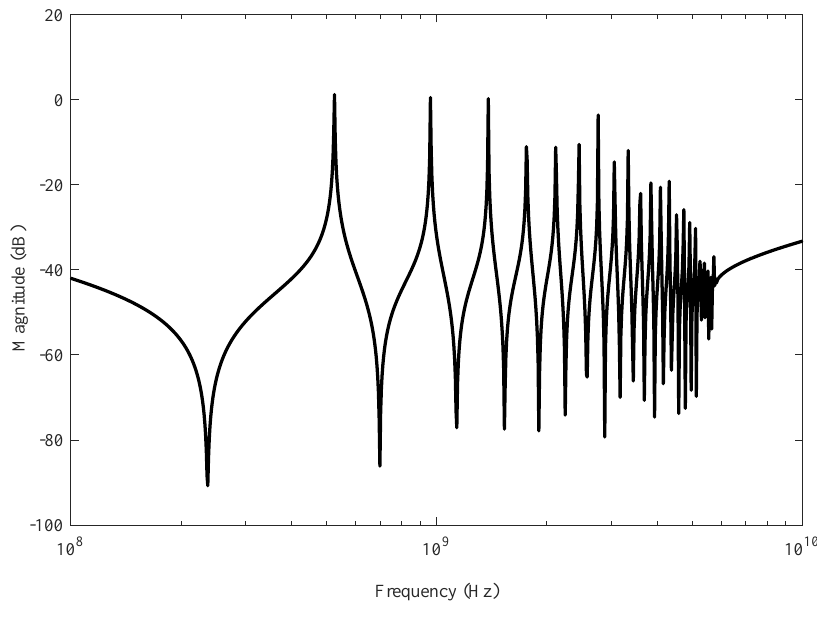
Figure 2. Original system frequency response of a on-chip 79 order RLC